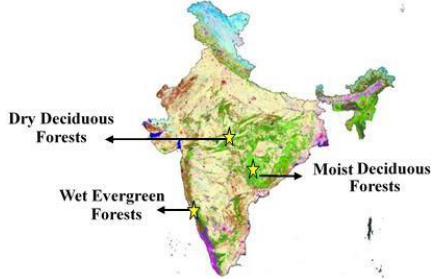
Figure 1. Location of selected forest type in India